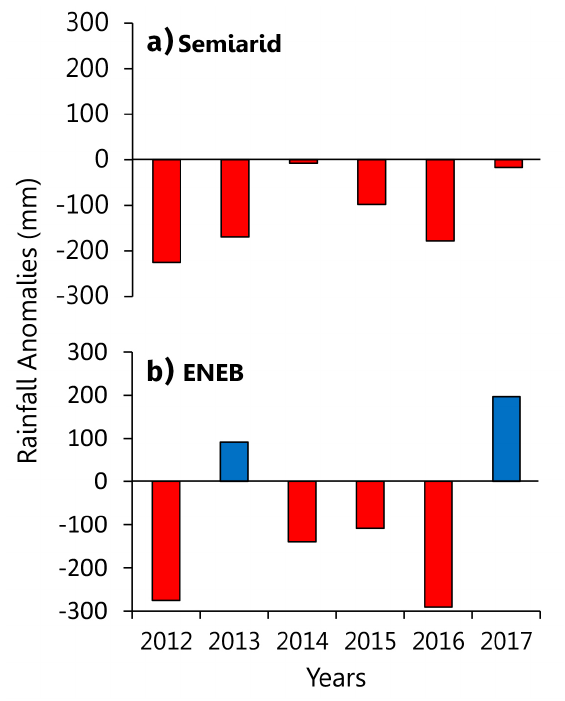
Figure 3. Time series of precipitation anomalies accumulated during the rainy seasons of the a northern semiarid region (FMAM) and b east coast of Northeast Brazil (AMJJ) extracted from GPCP satellite data during the 2012-2017 period. The anomalies were calculated based on the climatological average for